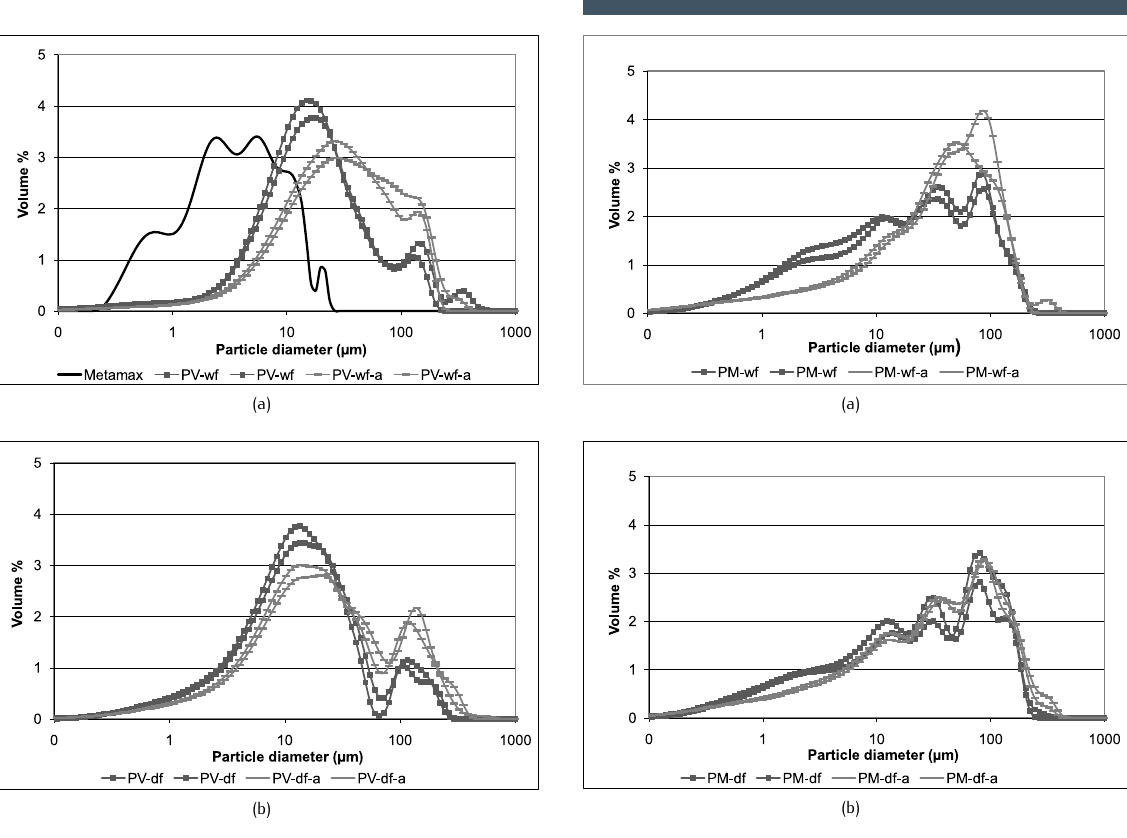
Figure 3. Particlesizedistributionofa)Metamaxandwetfractionated samples of PV and b) dry fractionated samples of PV.